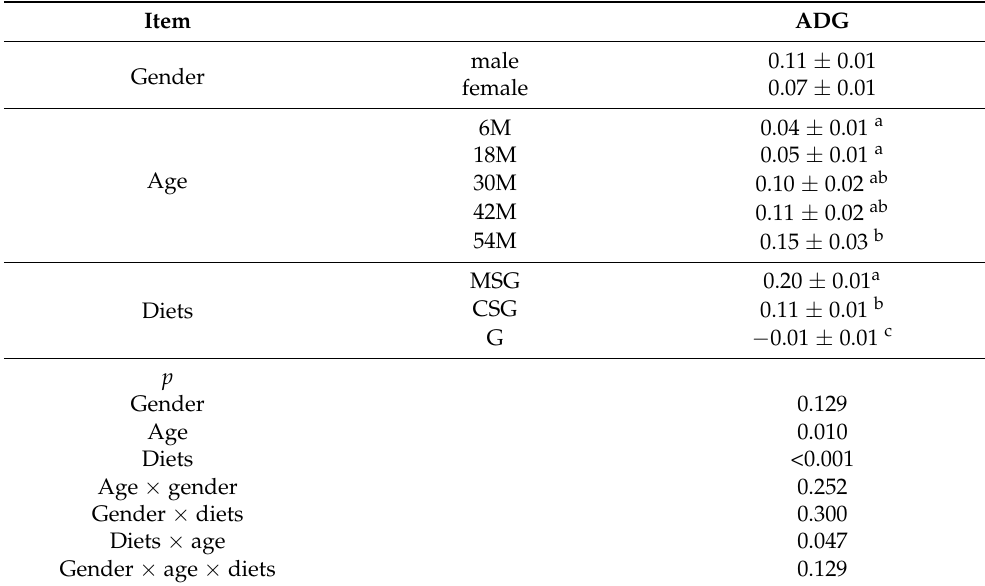
Table 5. Effect of different supplemental feeding on average daily gain of yaks of different genders and